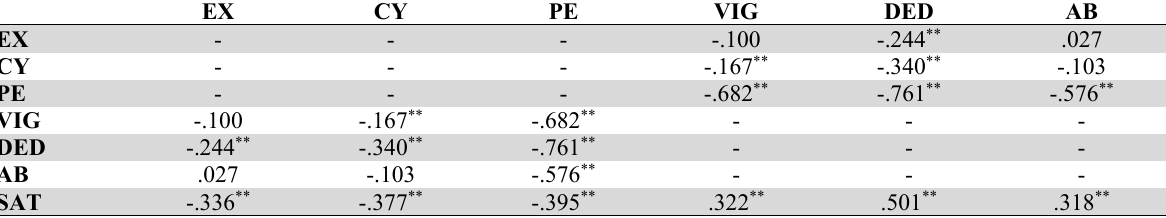
Correlations Between Maslach Burnout Inventory–Student Survey (MBI-SS), Utrecht Work Engagement Student (UWES- S) Scales and Major Satisfaction